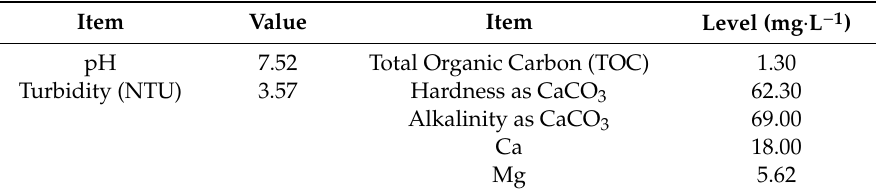
Table 1. Summary of key parameters in the river water.